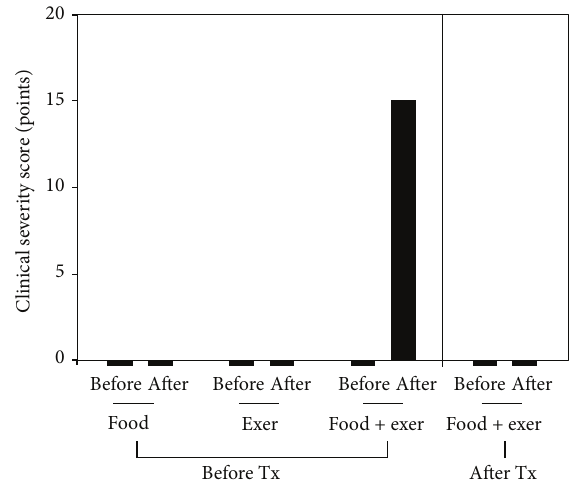
Figure 1: Diagnosis of food-dependent exercise-induced anaphy- laxis (FDEIA) and the changes of clinical severity by oral challenge test and exercise provocation test (Case 1). Before: before challenge orexercisestimulation;after:afterchallengeorexerciseprovocation; food, oral challenge test for wheat; exer: exercise provocation test; food + exer: Exercise provocation just after intake of wheat; Tx: specific oral tolerance induction using IFN-gamma for wheat.